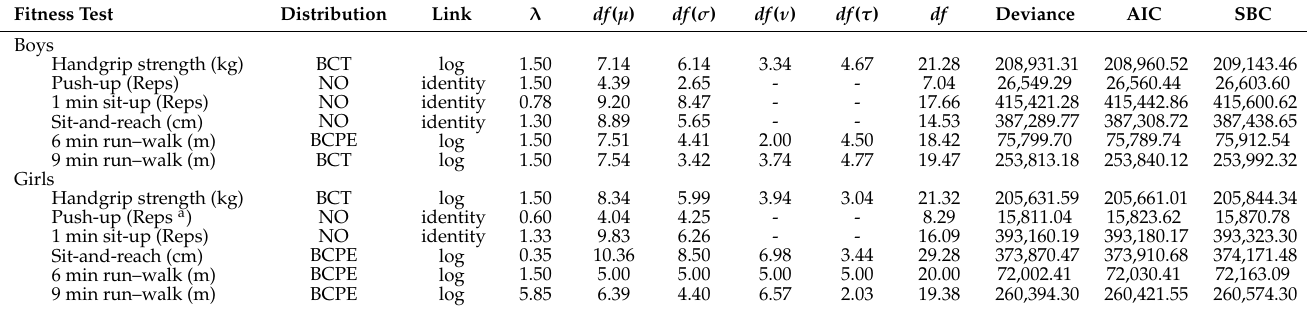
Table 3. GAMLSS models for fitness tests among 6 to 17-year-old Hong Kong children and adolescents.